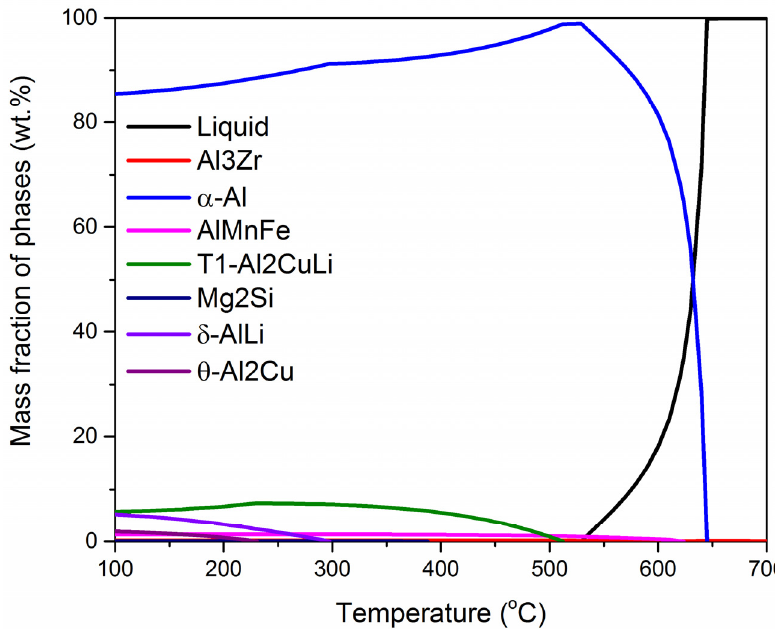
Figure 1. The equilibrium phase diagram of 2A97.